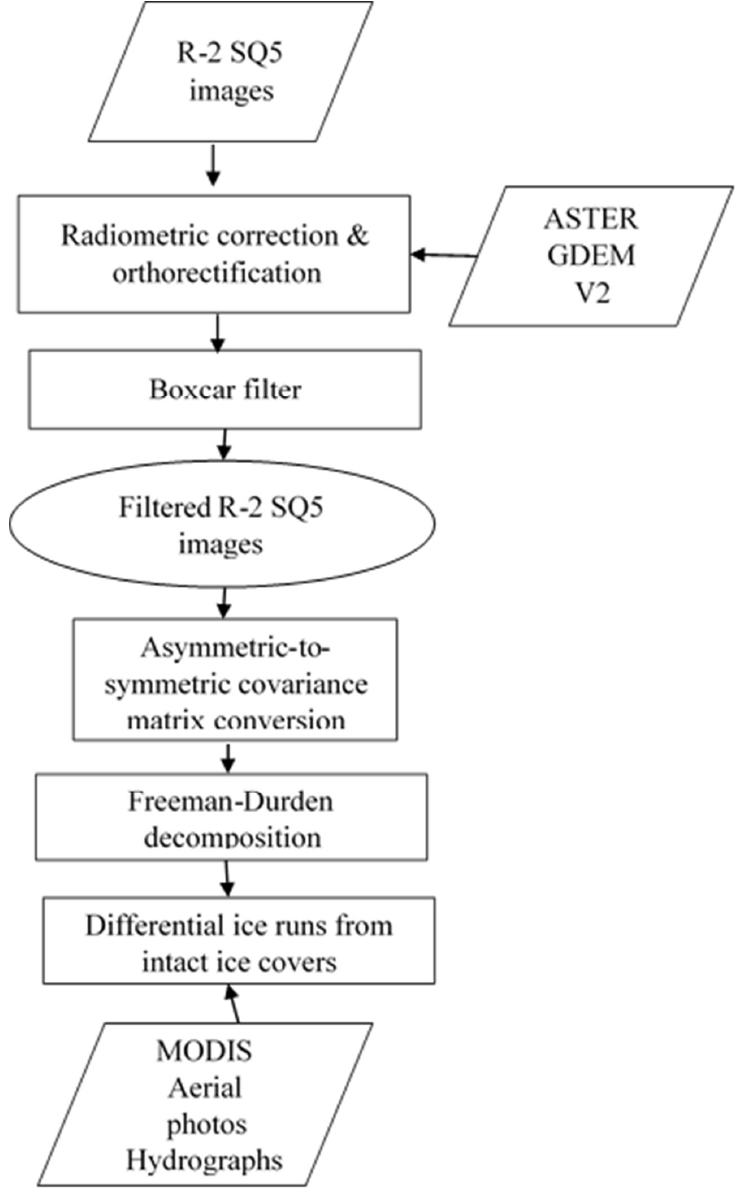
Figure 3. The procedures of image processing and differentiation of ice covers of ice runs and intact ice